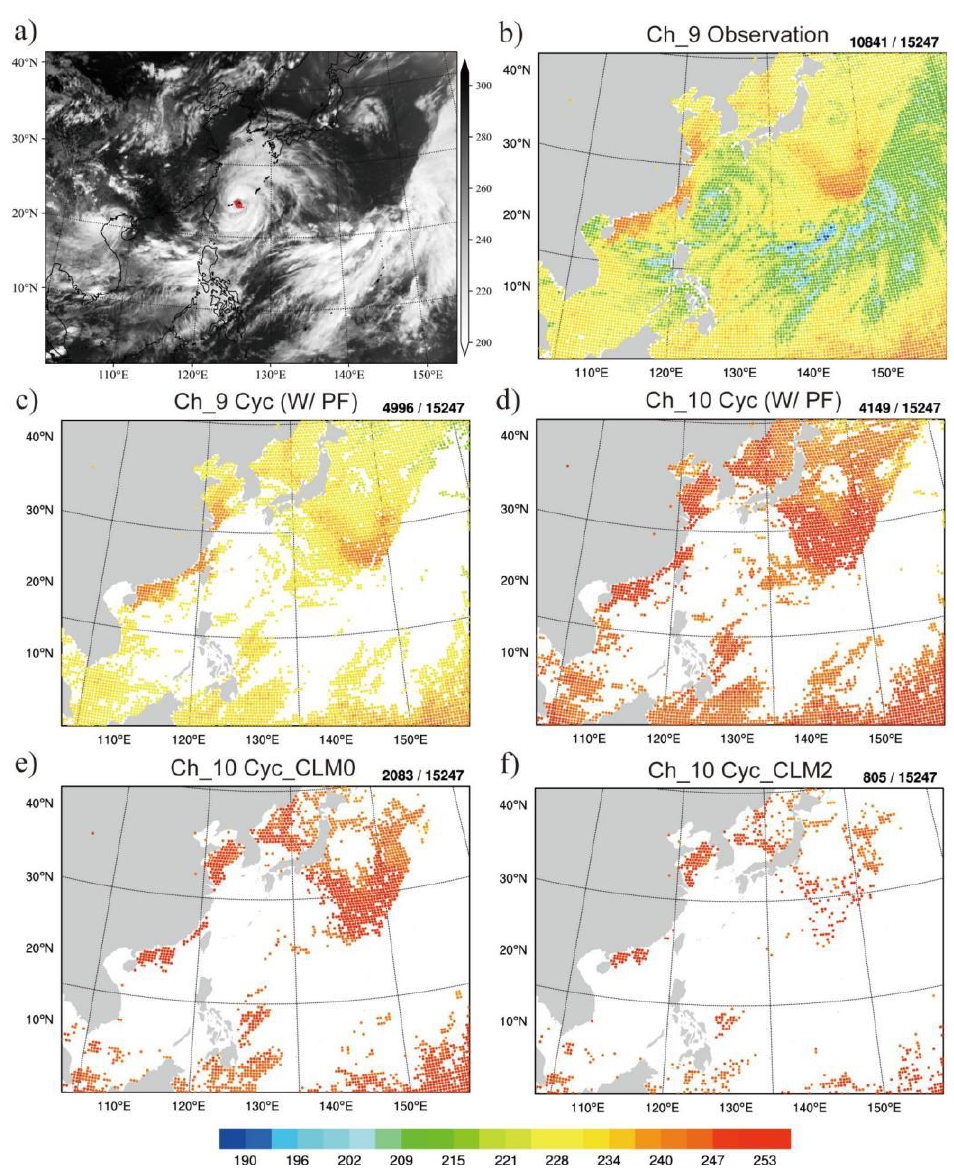
Figure 5. ( a ) The brightness temperature of the AGRI window band 12 (with central wavelength of 10.8 µ m) with the location of Typhoon In-Fa (denoted by a red mark). The observed brightness temperature (unit: K) distributions from ( b ) the observation without QC for channel 9, ( c ) the Cyc experiment with the PF method for channel 9, ( d ) the Cyc experiment with the PF method for channel 10, ( e ) the Cyc_CLM0 experiment for channel 10, and ( f ) the Cyc_CLM2 experiment for channel 10 valid at 0600 UTC 23 July 2021. The numbers on the top right represent the used-data counts versus the total-data counts in each assimilation experiment.